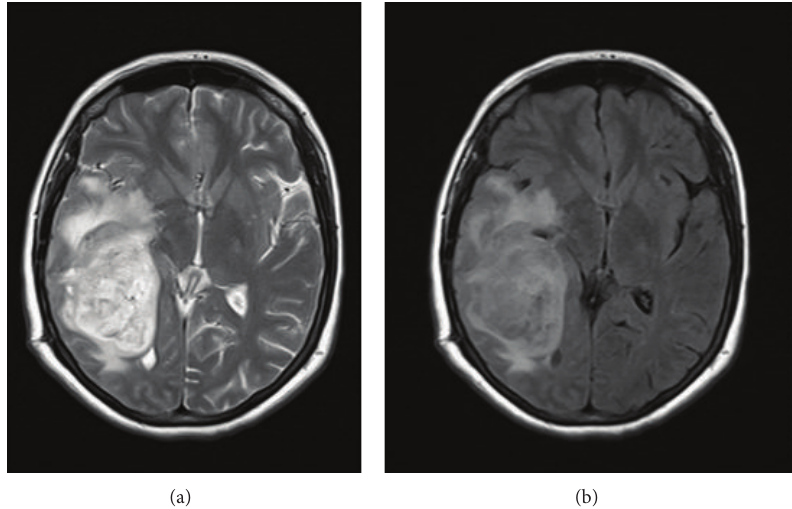
Figure 3: T2 weighted (a) and (b) FLAIR MR images of the lesion before second operation on axial plane showing a recurrent lesion with prominent peripheral edema and minimal midline shift at the same location.